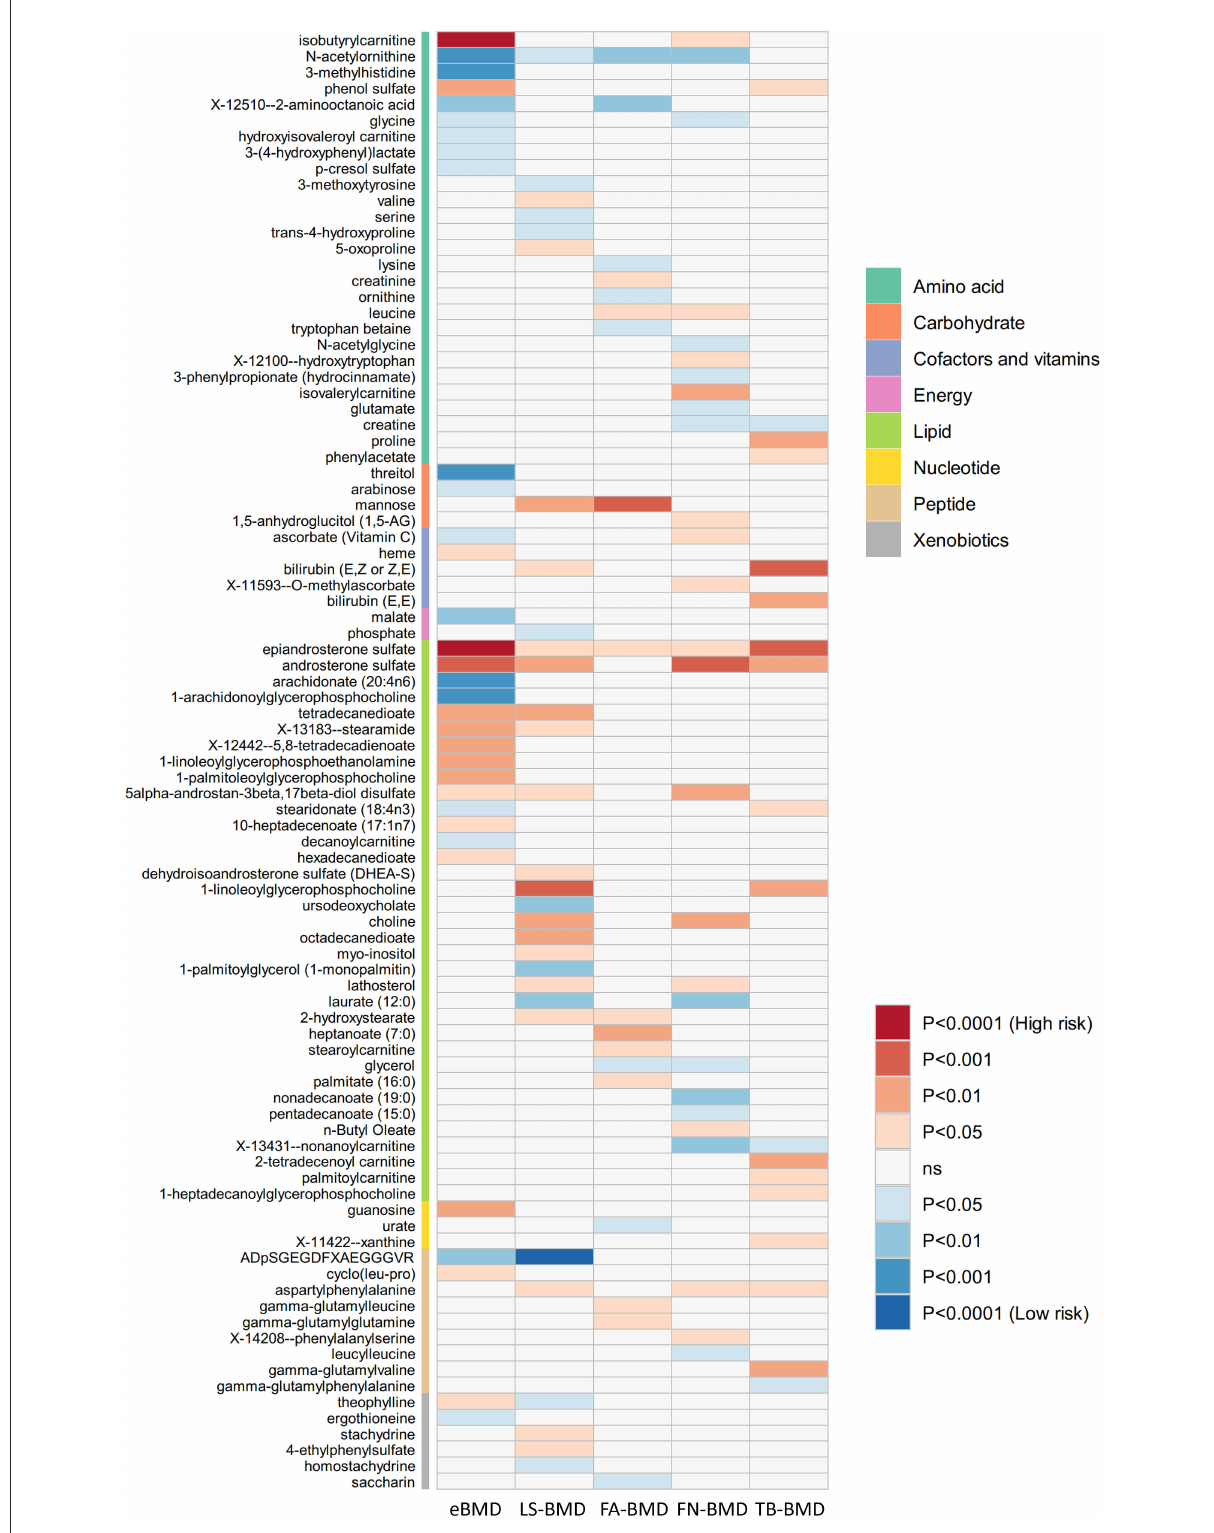
FIGURE3 Mendelian randomization associations of serum metabolites on five BMD phenotypes that derived from the IVW analysis. IVW, inverse-variance weighted; eBMD, estimated bone mineral density; TB-BMD, total body bone mineral density; LS-BMD, lumbar spine bone mineral density; FA-BMD, forearm bone mineral density; FN-BMD, femoral neck bone mineral